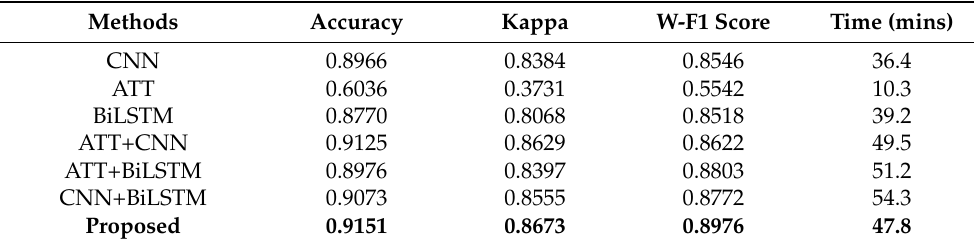
Table 10. Comparison of experimental ablation models.